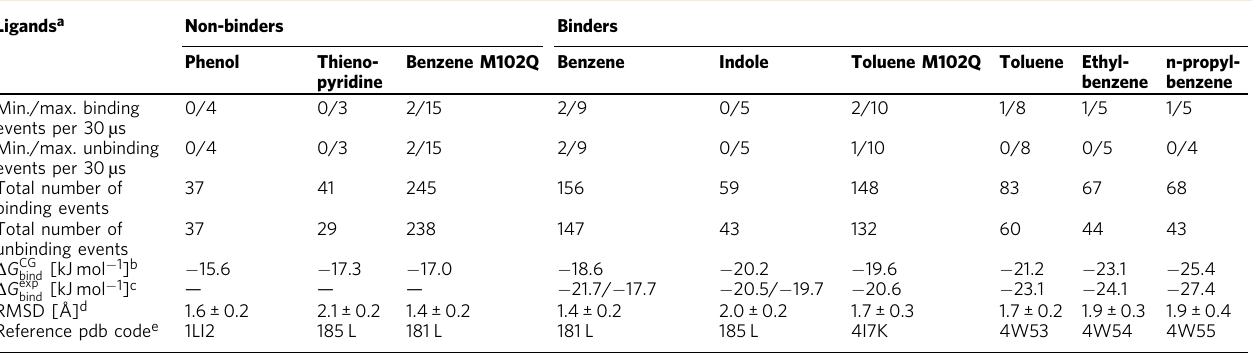
a Ligand namescontaining “ M102Q ” indicate the systemssimulated with the L99A/M102Q double mutant of T4 lysozyme. Therest of the MD simulations were performed with the single mutant L99A. b Binding free energies ( Δ G CG bind ) are computed from radial ligand-receptor potentials of mean force obtained from unbiased MD simulations, as described in Methods. c The fi rst experimental binding free energy ( Δ G exp 18,44,97,98 . Where a second value is given, this is taken from NMR experiments 99 . bind ) corresponds to calorimetric data taken from refs. d The RMSD is calculated for the binding pocket residues and ligand after aligning the binding pocket residues to the respective crystal structure (for details see Supplementary Methods). e Crystal structures taken from ref. 43 . (benzene, indole) and 45 (toluene, ethylbenzene, and n-propylbenzene). Because no crystal structures are available for non-binders, the experimental binding mode of phenol M102Q 44 , indole 43 , and benzene 43 were used as references the structure to compute the RMSD for phenol, thieno-pyridine, and benzene M102Q,